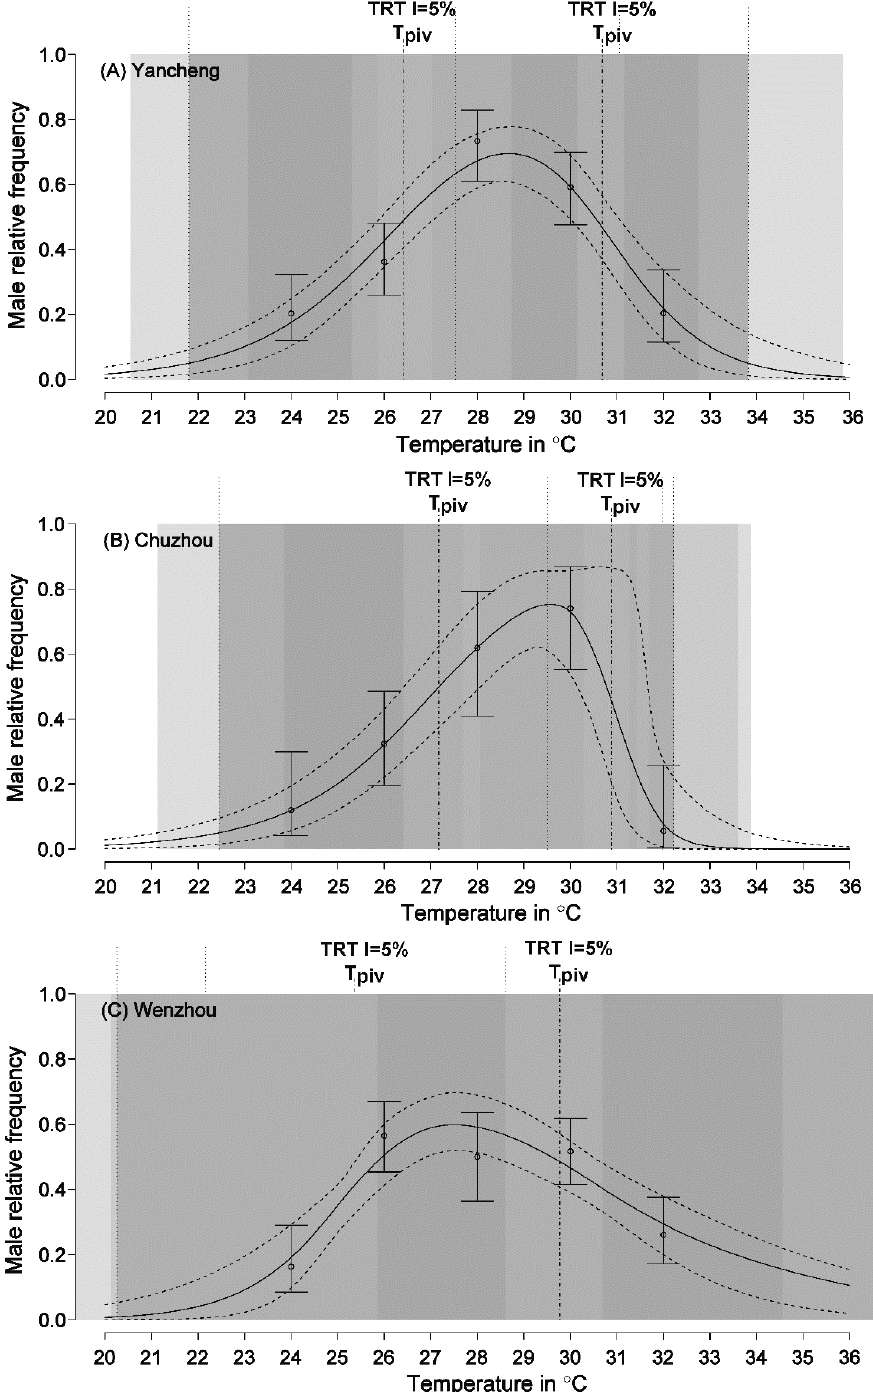
Figure 1. Patterns of temperature-dependent sex determination in Gekko japonicus from three populations modeled by a logistic function and fitted using Bayesian MCMC. ( A ) Yancheng, ( B ) Chuzhou, and ( C ) Wenzhou. The points indicate observed sex ratios and the bars represent their 95% confidence intervals. The vertical dash-dotted lines depict pivotal temperatures (T piv ). The dark gray zones represent the transitional range of temperatures (TRT) and the light gray zone represents the 95% confidence of the TRT. The vertical dotted lines represent the lower and higher limits of TRT. The plain solid curves depict the thermal reaction norm for sex ratios associated with dashed curves which represent a 95% confidence